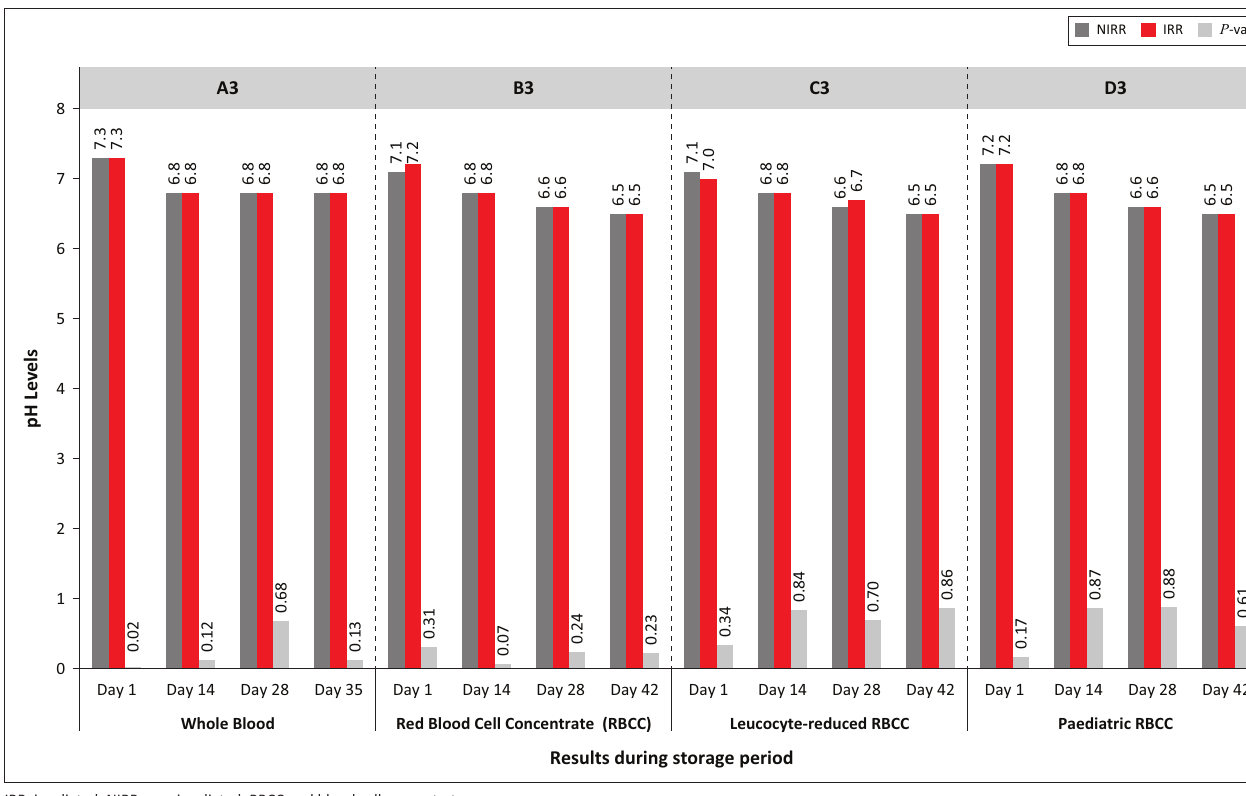
IRR, irradiated; NIRR, non-irradiated; RBCC, red blood cell concentrate FIGURE 3: pH levels.